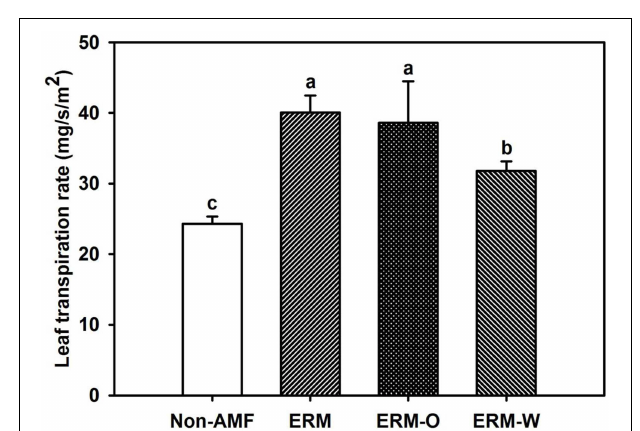
FIGURE 5 | Effect of extraradical mycelium (ERM) status on leaf transpiration rate in trifoliate orange ( Poncirus trifoliata ) seedlings inoculated with or without Funneliformis mosseae and grown in 37 µ m nylon-mesh separated root/hyphae compartments. Data (means ± SD, n = 3 ) followed by different letters above the bars among treatments indicate significant differences at the 5% level. Abbreviation: ERM, the plants of the root compartment carrying inoculation with Funneliformis mosseae ; ERM-O, the plants of the root compartment carrying inoculation with F. mosseae , coupled with an ERM network of air gap cut only one time before 8h of the harvest; ERM-W, the plants of the root compartment carrying inoculation with F. mosseae , coupled with an ERM network of air gap cut at weekly interval after 14 days of inoculation; Non-AMF, the plants of the root compartment carrying the inoculation without F. mosseae